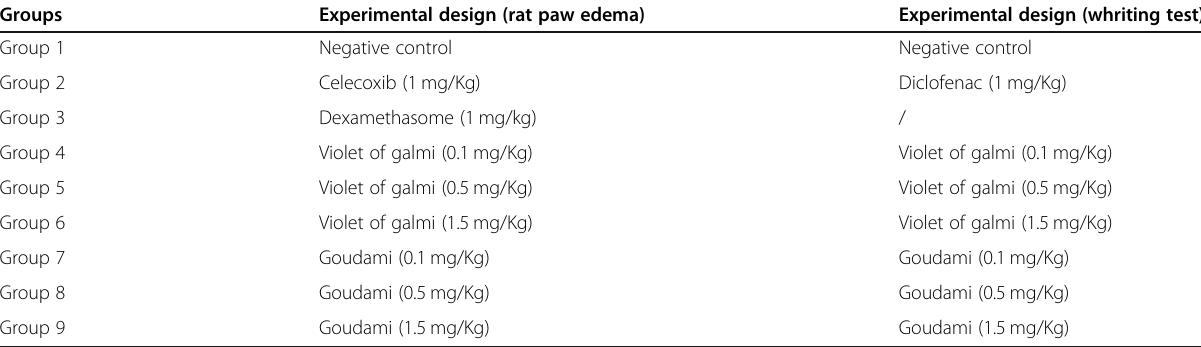
Table 1 Experimental designs for in-vivo animal models of inflammation